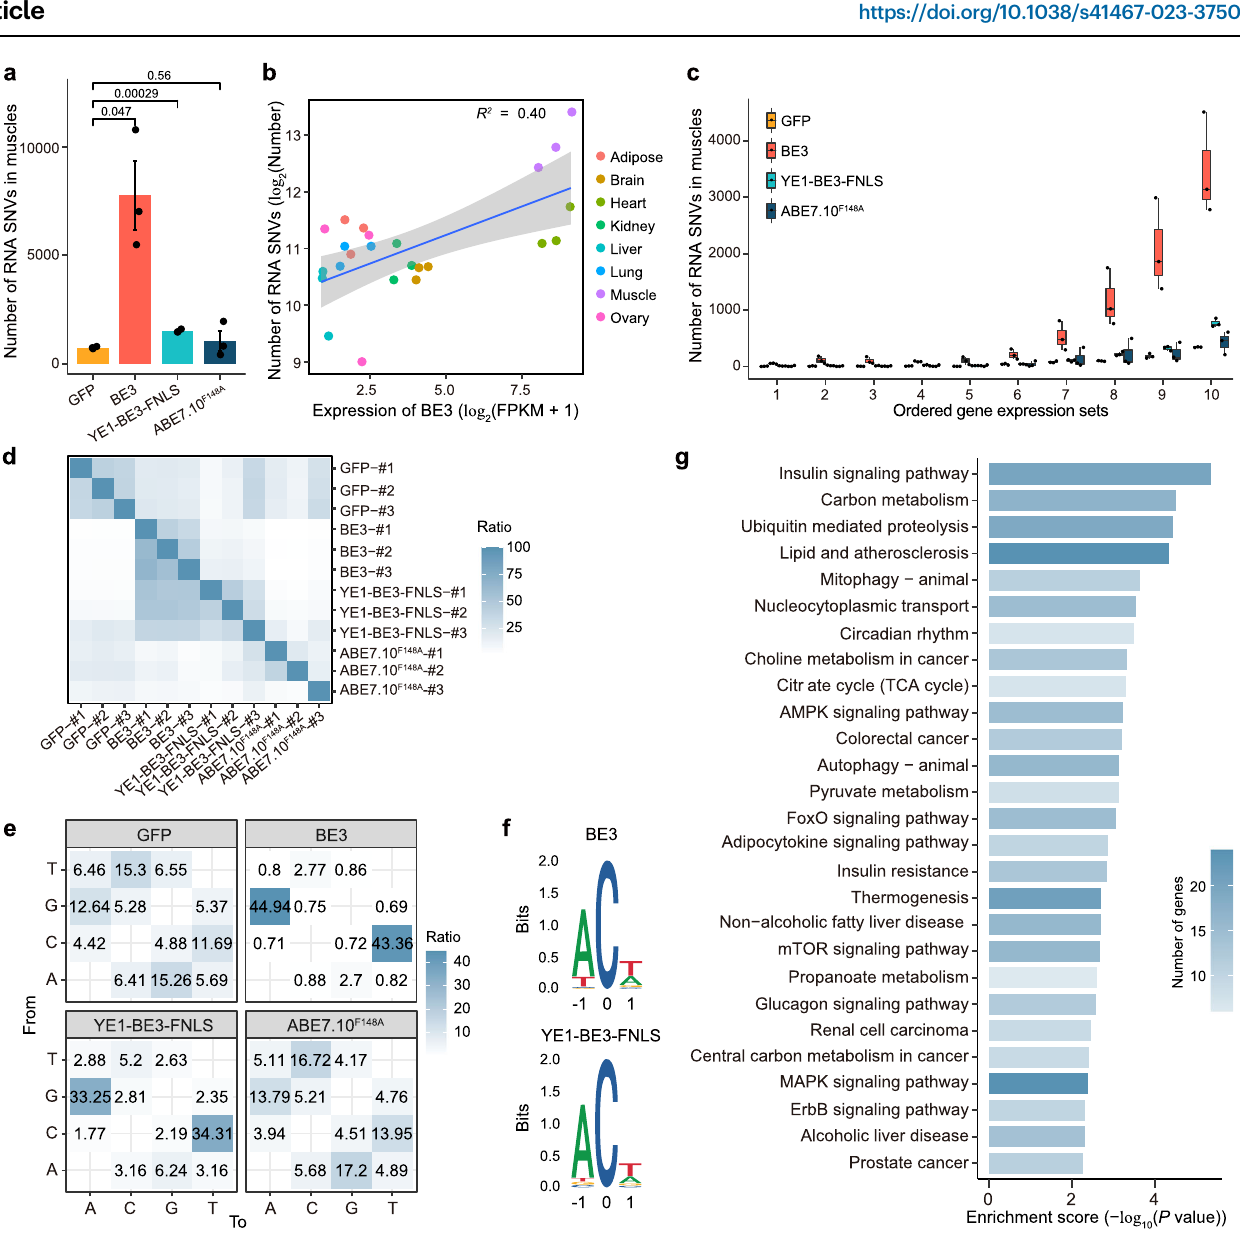
overlappingRNASNVsbetweentwosamplesdividedbythenumberofRNASNVsin the row. n = biologically independent samples. e Distribution of mutation types in muscles of the GFP, BE3, YE1-BE3-FNLS, and ABE7.10 F148A mice. The number indi- cates the percentage of a certain type of SNVs among all SNVs. f Sequence logos derivedfromRNASNVsinmusclesoftheBE3andYE1-BE3-FNLSmice.Analysiswas performed on generated RNA-seq data using cDNA, and thus every T depicted should be considered a U in RNA. g Kyoto Encyclopedia of Genes and Genomes (KEGG) pathway enrichment analysis of the RNA SNVs detected in muscles of the BE3 transgenic mice. Genes with a change in expression > 2.0-fold compared with the baseline value and with a P value<0.05 were selected for analysis. Source data are provided as a Source Data fi